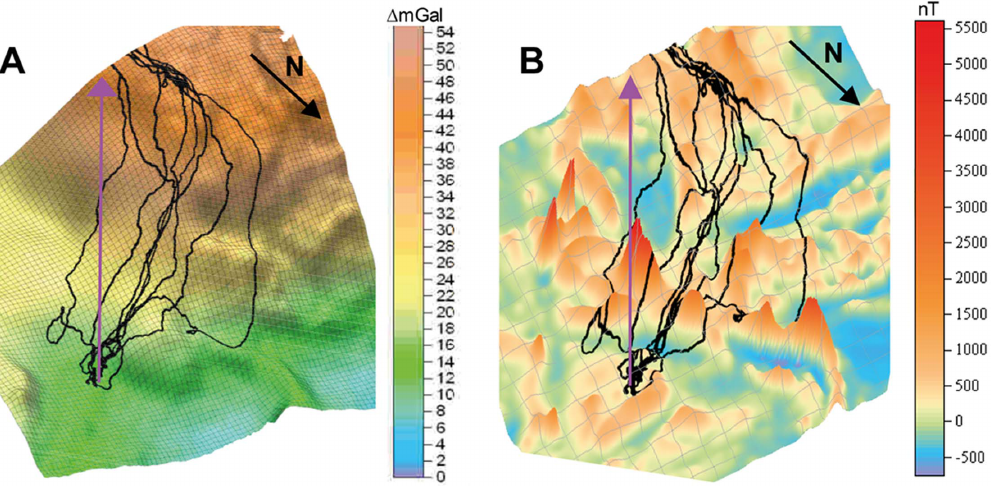
Figure 8. Last training release of Z-pigeons northeast of the Zavallia loft. (A) Flight tracks on gravity anomaly map. Most birds appear to follow the steepest gravity gradient of the anomaly, then turn left when they hit the Bug river. Scale 0–54 D mGal. (B) Flight tracks on magnetic anomaly map, showing partial coincidence of magnetic and gravity anomalies. Scale -500 to 5’500 nT. Violet arrow shows home direction. For a topographical map: